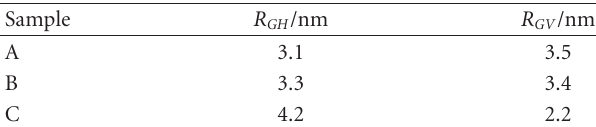
Table 2: The Guinier radii, R GH , and R G V for samples A, B, and C, calculated from vertical and horizontal intensity cuts.